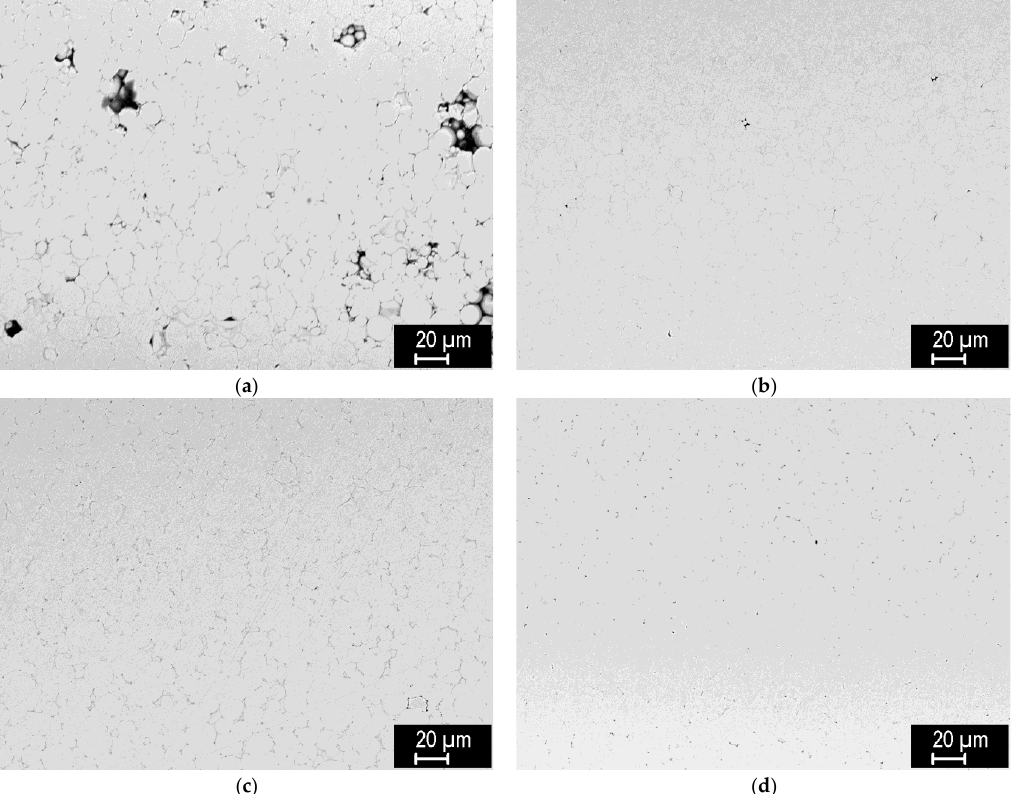
Figure 6. Microstructures of the steel compacts (central regions) sintered at ( a ) 800 °C, ( b ) 900 °C, ( c ) 1000 °C, ( d ) 1100 °C.